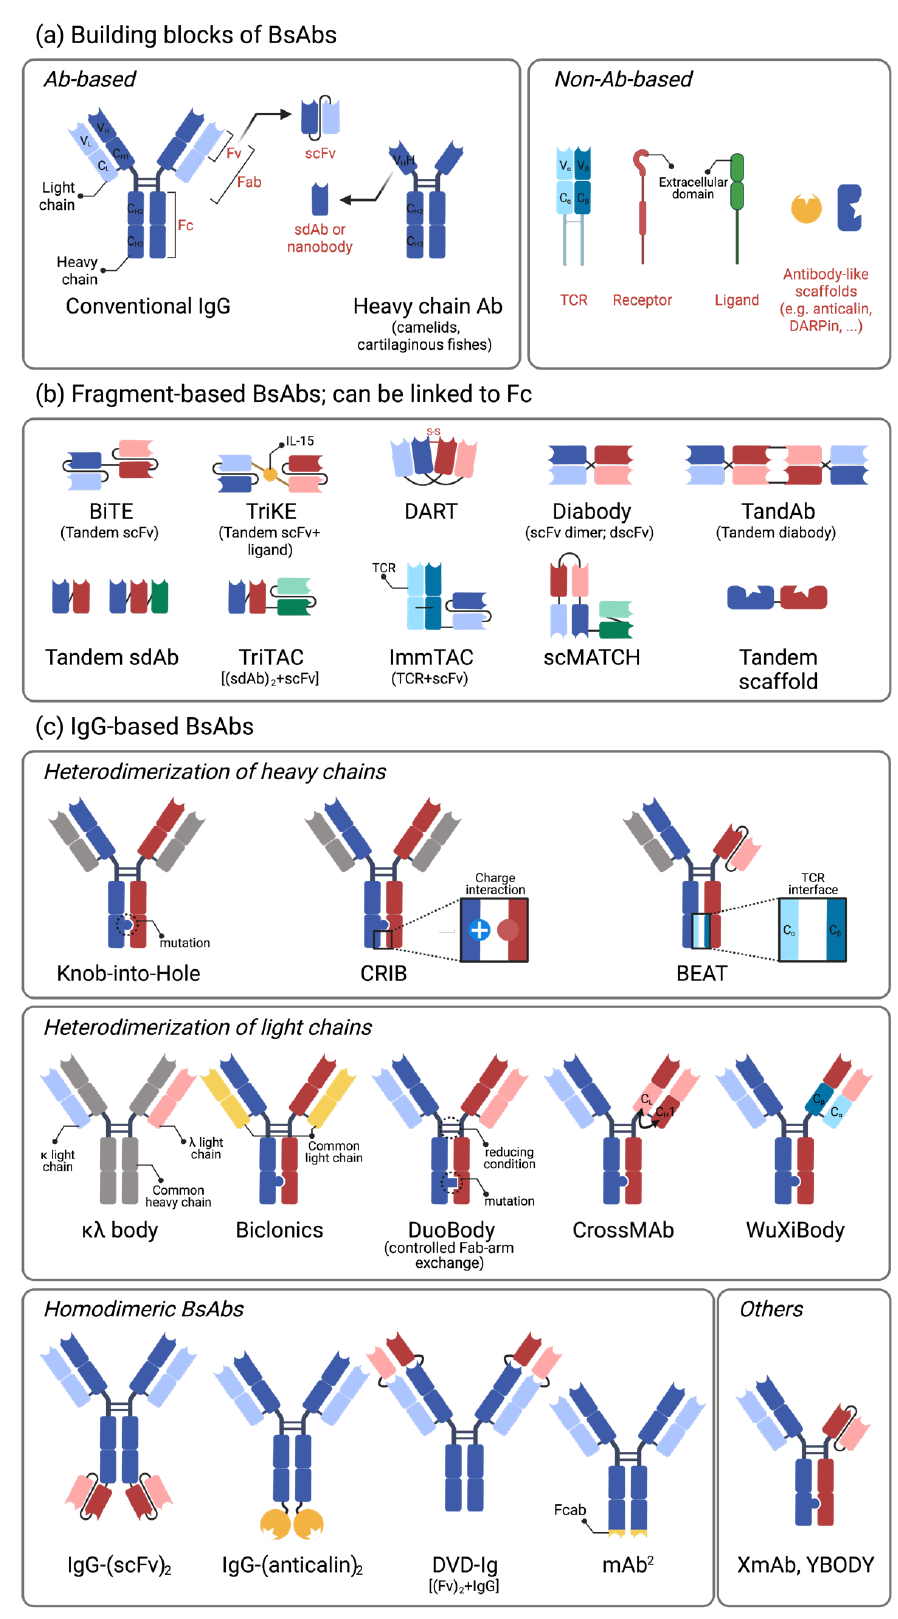
Figure 1. The building blocks and formats of bispecific antibodies. ( a ). The building blocks of BsAbs. Most BsAbs consist of antibody-based fragments (Fv, Fab, Fc, scFv, and sdAb), and some BsAbs include non-antibody-based proteins such as